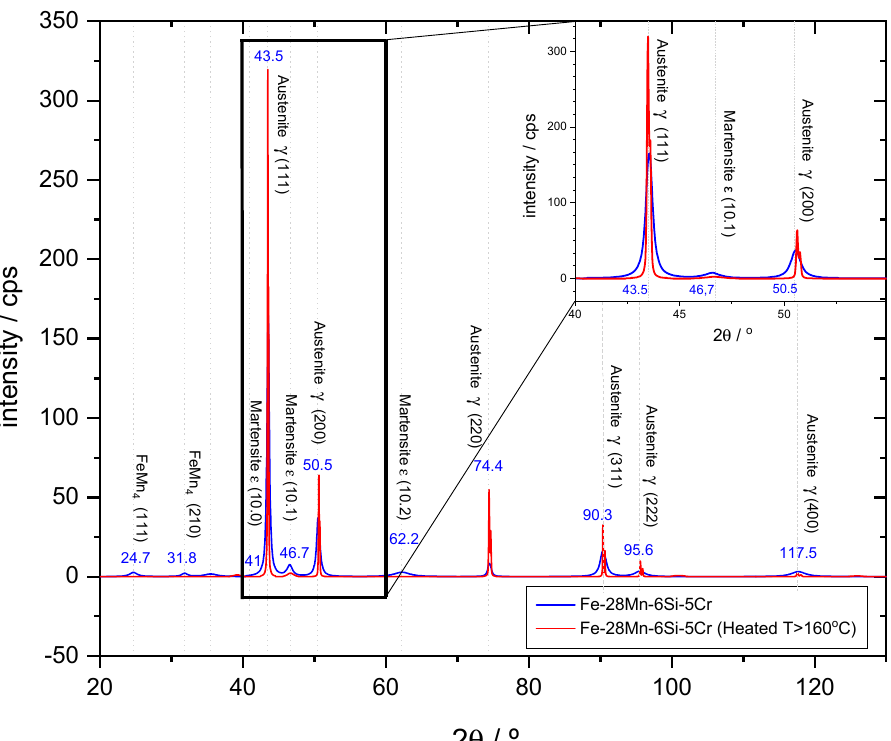
Figure 5. XRD diffractograms of the SMS alloy in pre-strained state (blue) and after thermal activation at 160 °C during 5 min (red). A detailed insert of 2 θ between 40 and 60° is provided. Table 2. Peak intensity ratio (I/I max ) and FWHM corresponding to the characteristic diffraction peaks of the γ -austenite.